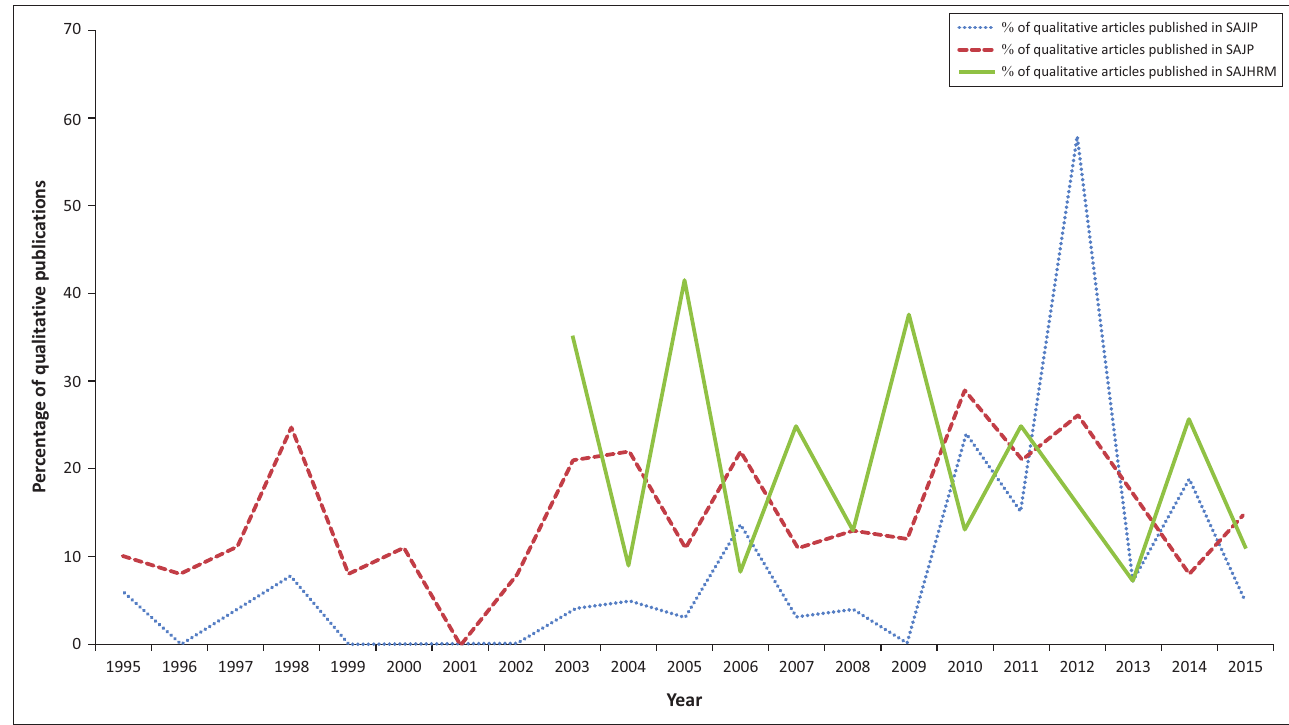
FIGURE 1: Trends over the years in the percentage of qualitative publications per